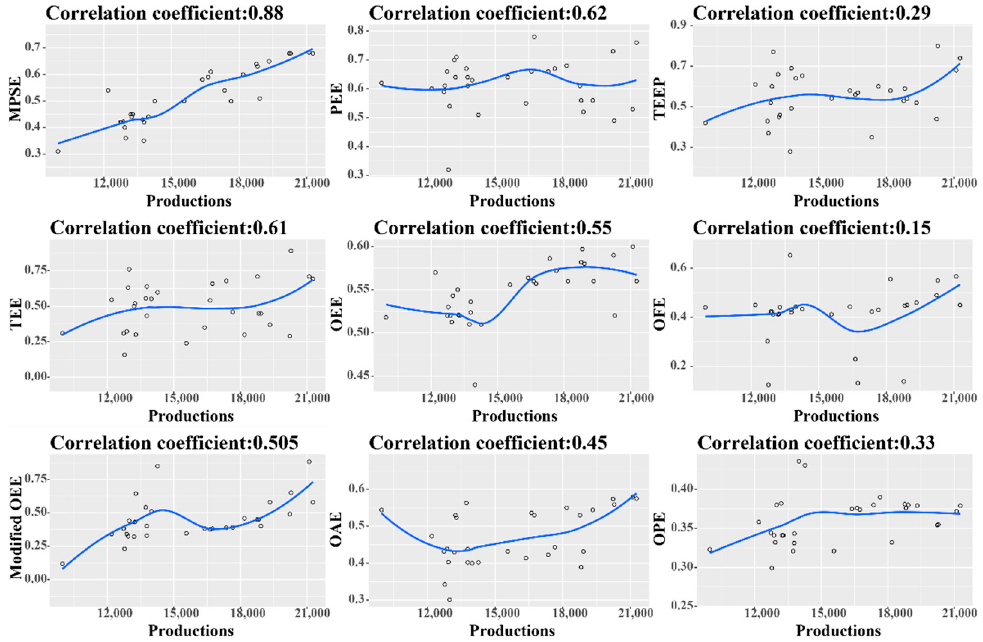
Figure 9. Pearson correlation coefficients between different measurement methods and productions.